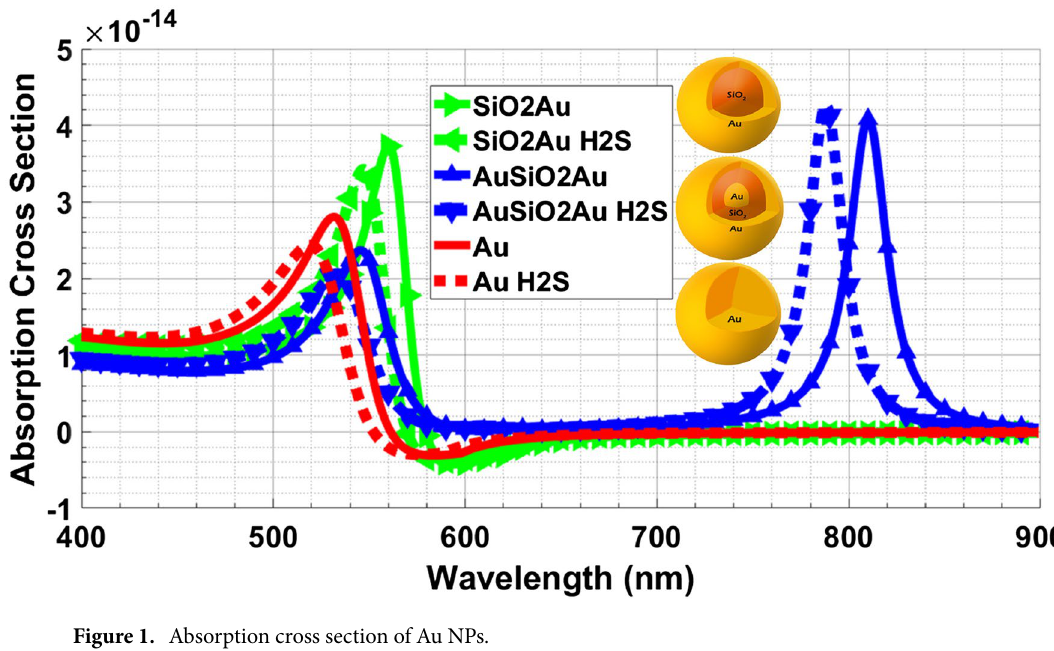
Figure 1. Absorption cross section of Au NPs.